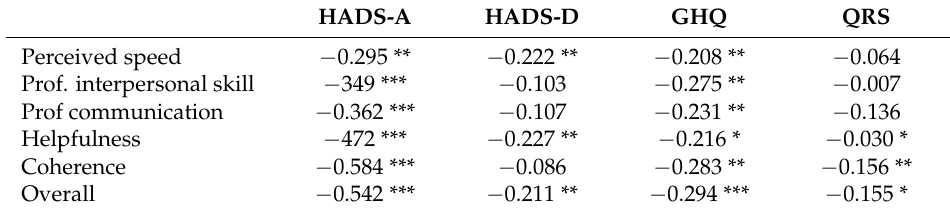
Table 4. Correlations between parent views of the diagnostic process and parents’ self-reports of health (HADS-A = anxiety; HADS-D = depression; GHQ = health relayed quality of life; QRS = parenting stress). HADS-A HADS-D GHQ QRS Perceived speed − 0.295 ** − 0.222 ** − 0.208 ** − 0.064 Prof. interpersonal skill − 349 *** − 0.103 − 0.275 ** − 0.007 Prof communication − 0.362 *** − 0.107 − 0.231 ** − 0.136 Helpfulness − 472 *** − 0.227 ** − 0.216 * − 0.030 * Coherence − 0.584 *** − 0.086 − 0.283 ** − 0.156 ** Overall − 0.542 *** − 0.211 ** − 0.294 *** − 0.155